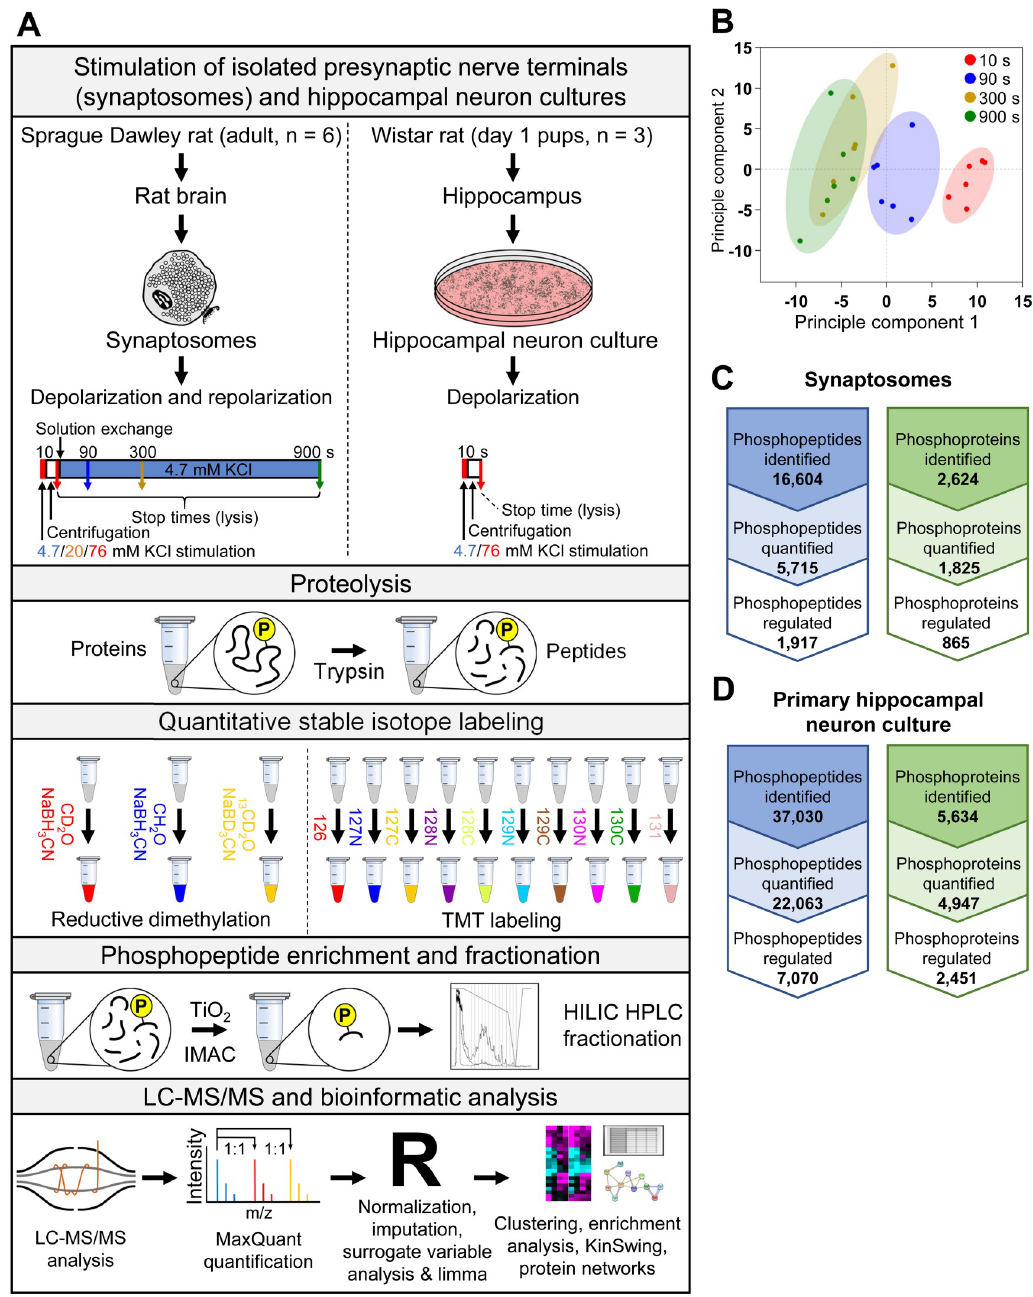
Fig 1. Quantitative analysis of activity-dependent phospho-signalling in synaptosomes and hippocampal neurons. (A) The experimental workflow started with either synaptosomes from the whole brain of adult rats or cultured primary hippocampal neurons. Shown is a schematic of the stimulation protocol for synaptosomes and neurons and the time points examined. Only the synaptosomes were repolarized by including a centrifugation and solution exchange step and were studied for the temporal evolution of phospho-signalling. The lysed samples were digested, enriched for phosphopeptides, analyzed by quantitative phosphoproteomics, and processed using a bioinformatics approach that included determination of inferred protein kinase activity using KinSwing. (B) Principal component analysis of the processed time course data for 76 mM KCl stimulation. All six biological replicates for each time point are shown in the same colour. Counts of the phosphopeptides and phosphoproteins identified are shown for (C) synaptosomes and (D) primary hippocampal neurons. The counts were calculated with and without filtering for phosphorylation site localization and quantification confidence. The phosphopeptide data are available in S1 Table. The synaptosome data are the result of six independent experiments for each stimulation condition (20 mM and 76 mM KCl).